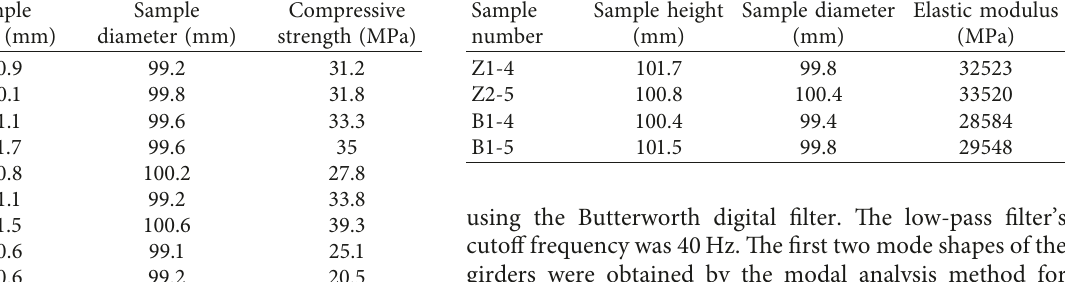
Table 2: Compressive strength test results of concrete. Sample Sample number